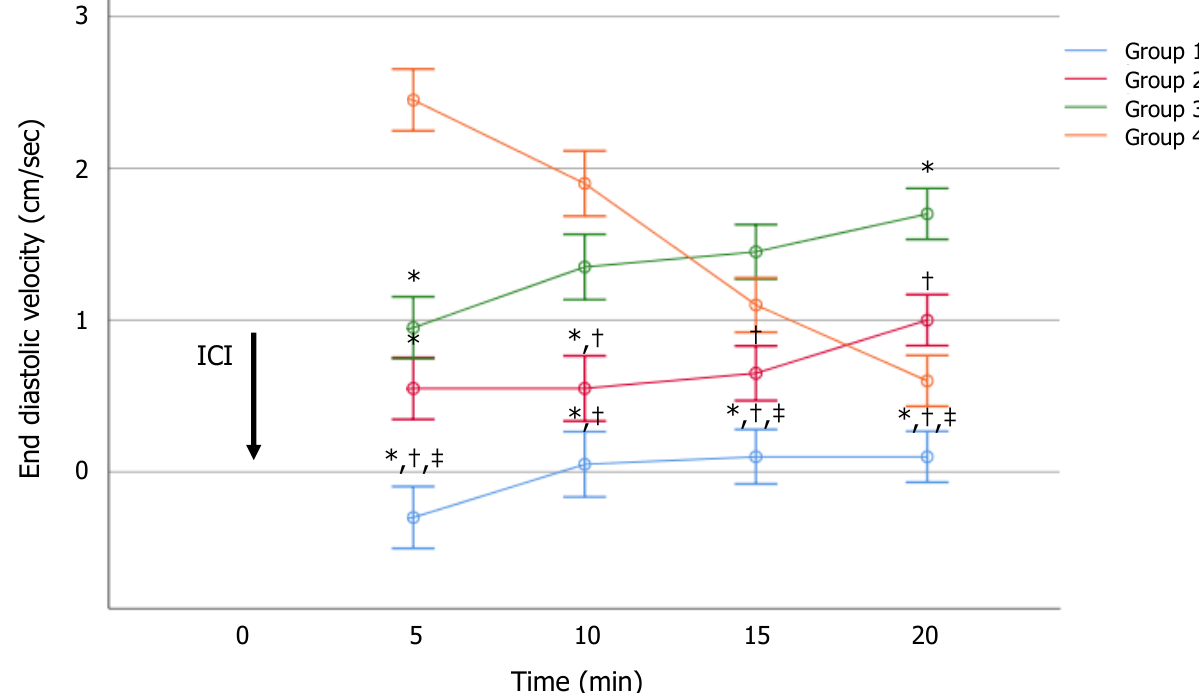
Figure 2. Effect of anxiety on the end-diastolic velocity after intracavernous injection (ICI) of alprostadil at serial times of assessment. The level of anxiety was assessed using the Generalized Anxiety Disorder (GAD-7) score. Values are expressed as mean ± standard error of the mean. * p < 0.05 vs. Group 4; † p < 0.05 vs. Group 3; ‡ p < 0.05 vs. Group 2, analyzed using the multivariate analysis of variance (MANOVA), with LSD post-hoc